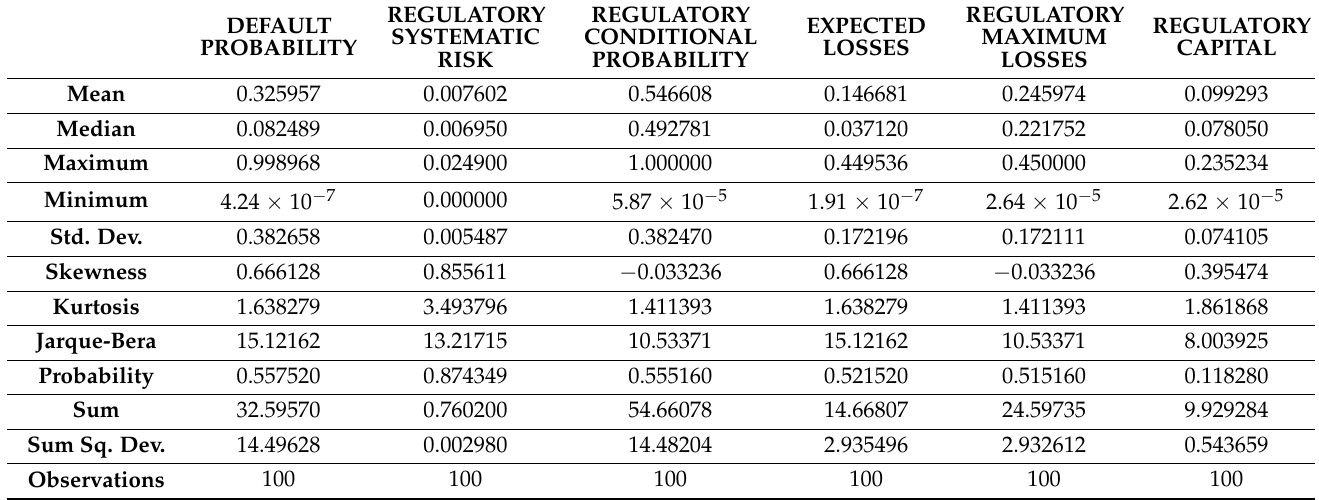
Table 4. Descriptive statistics: sensitivity to systematic risk and capital requirement according to the regulatory